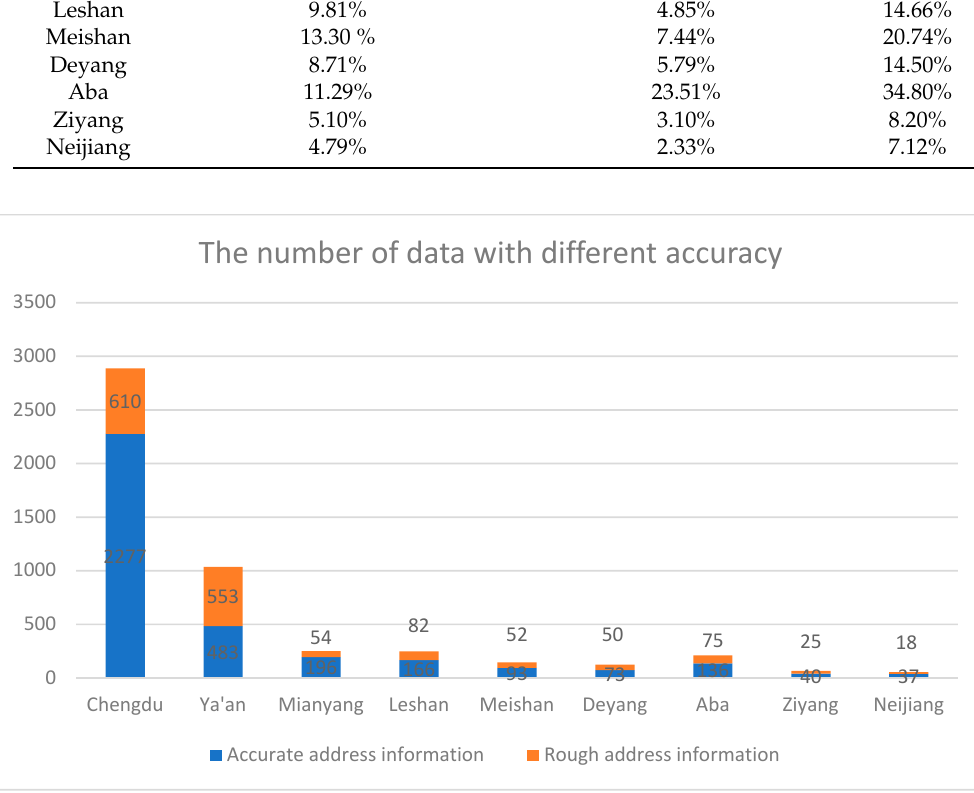
Figure 15. Comparison of the number of pieces of address information with different accuracy in each city.